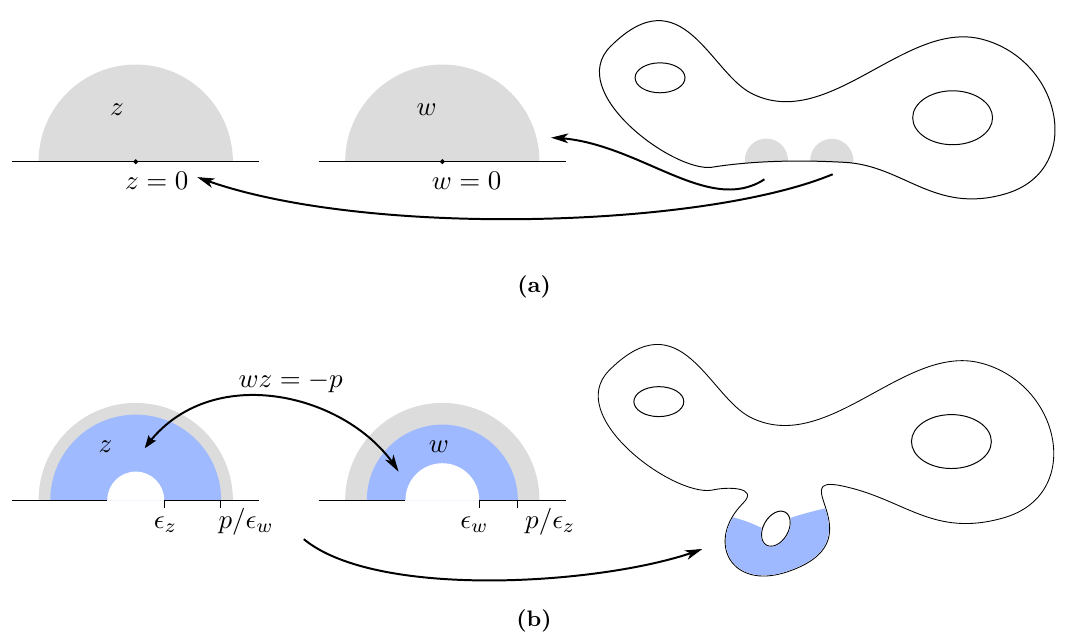
Figure 2. Given a bordered Riemann surface (cid:6) with two charts z and w which map the border of (cid:6) onto the real line and whose images include a neighbourhood of 0 ((cid:12)gure 2a), we can add an open string plumbing (cid:12)xture to (cid:6) ((cid:12)gure 2b) by imposing eq. (2.8) on a suitable domain. for (cid:15) < j w j (cid:20) p=(cid:15) and (cid:15) < j z j (cid:20) p=(cid:15) ((cid:12)gure 2b). The e(cid:11)ect of the plumbing (cid:12)xture is w z z w to add a ‘strip’ between the two charts on (cid:6), either by adding a loop or by joining